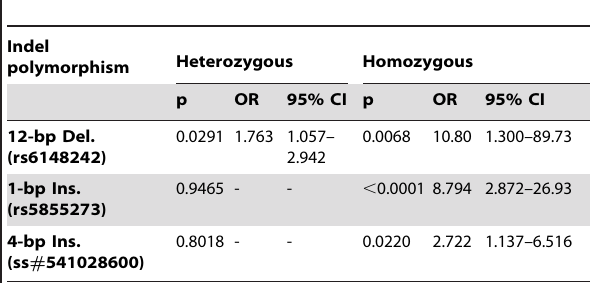
Table 3. Comparison of genotype frequencies between BEEC patients and normal controls.